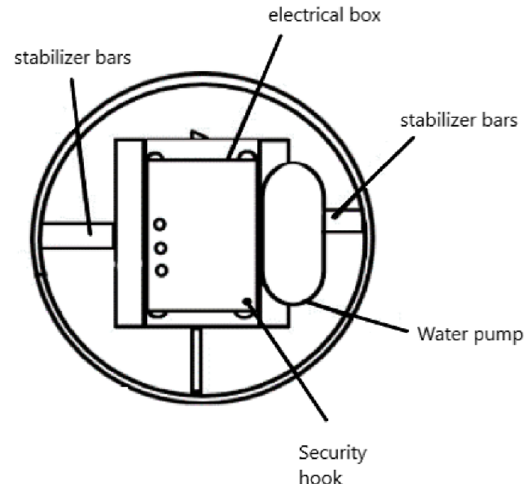
Figure 3. Top view. Figure 3. Top view.